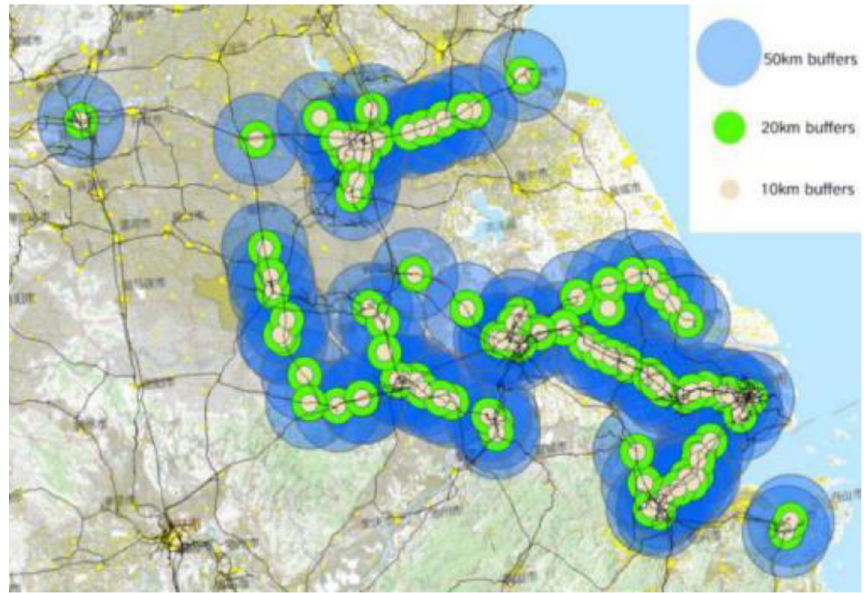
Figure 3. Buffers